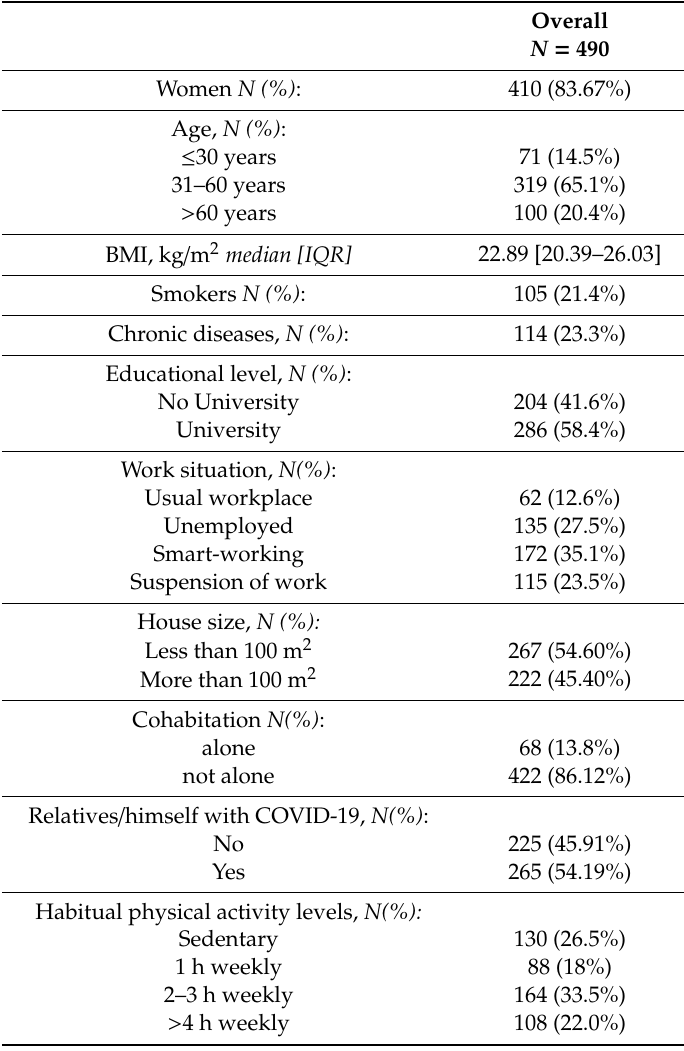
Table 1. Characteristics of the 490 subjects who participated in the